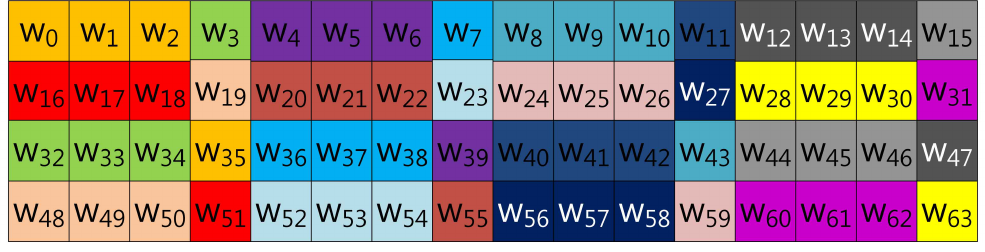
Figure 8. Look-up table structure of the (size-optimized) proposed method in block form for 4NAF (version